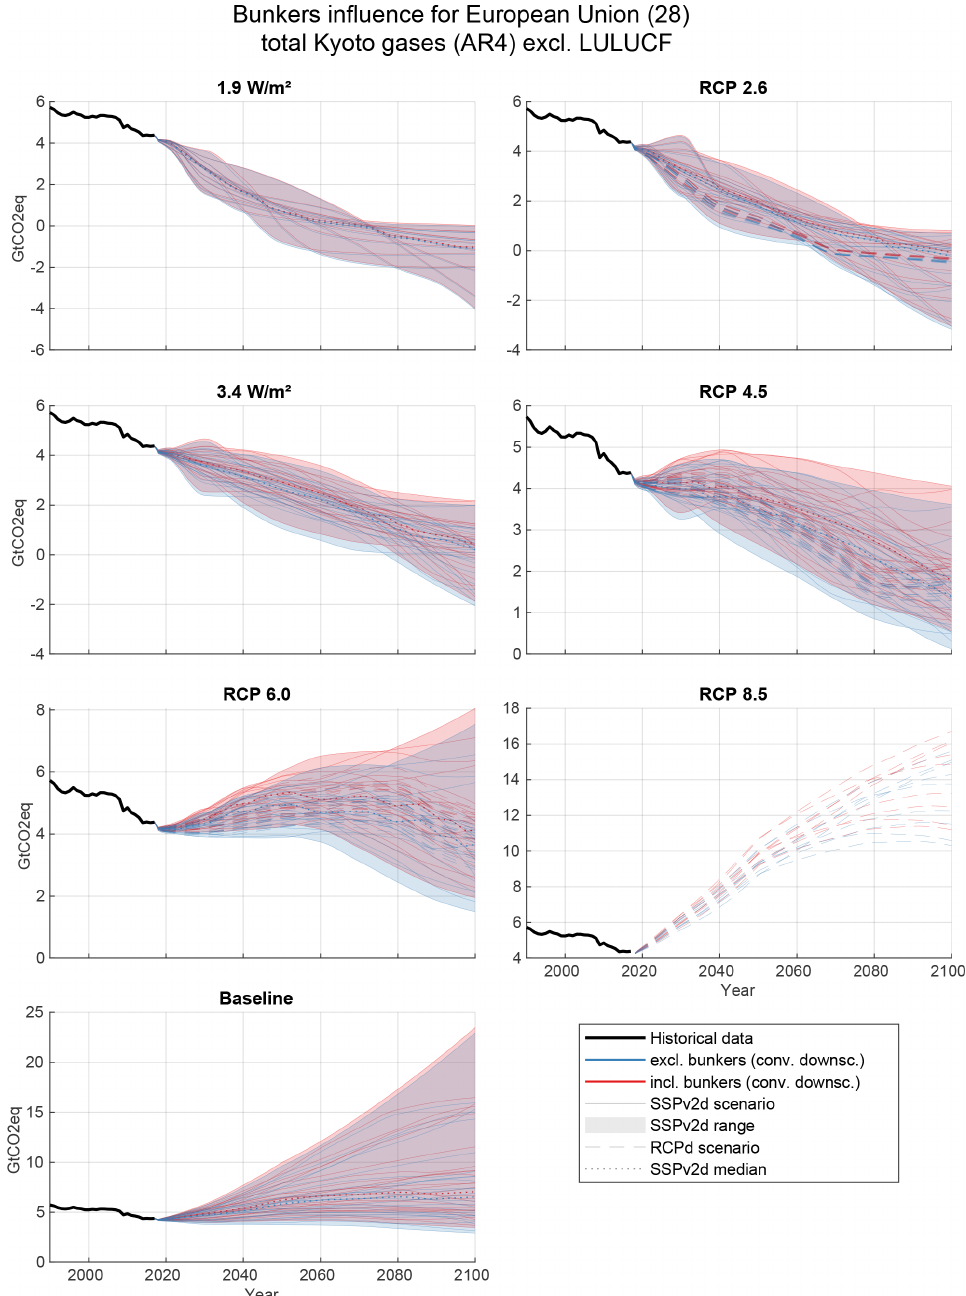
Figure 12. Influence of bunker emissions on results for the European Union. Ranges and the median are calculated over all SSPs and all IAM implementations in SSPv2d for each RCP. RCPd scenarios are shown as individual lines only (dashed). Absolute bunker emissions are high for higher emission scenarios; however, for low-emission scenarios bunker emissions can make the difference between net-negative and net-positive